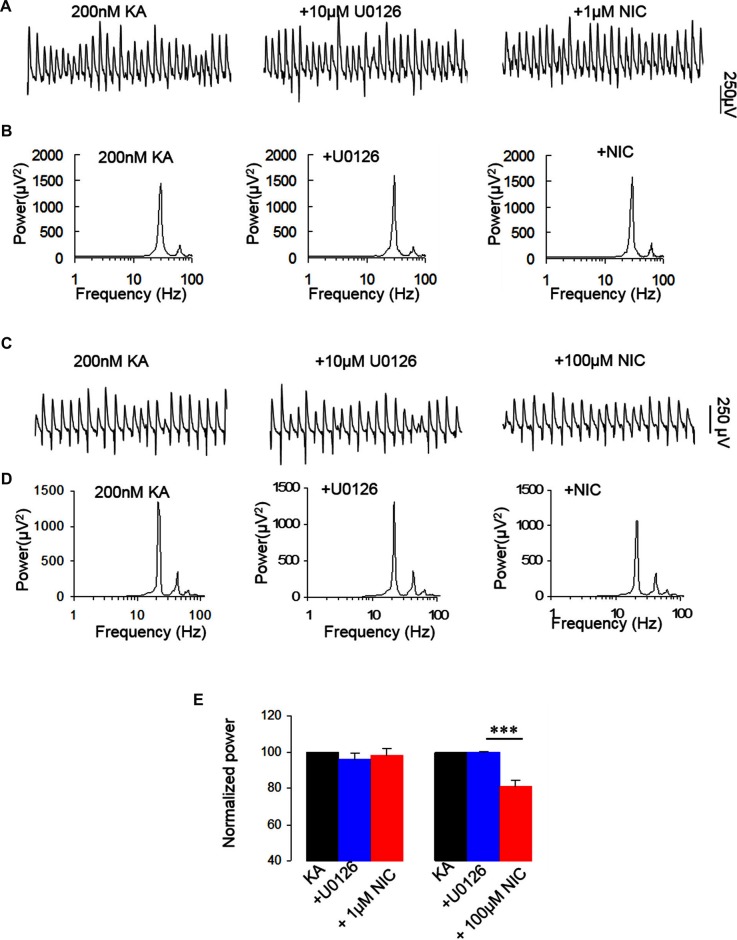
The effect of MEK kinase inhibitor on the nicotinic modulation of γ oscillations. (A,C) The extracellular field recordings from CA3 pyramidale for the kainate alone, in the presence of the ERK1/2 inhibitor, 10 μM 1,4-Diamino-2,3-dicyano-1,4-bis(o-aminophenylmercapto) butadiene (U0126; 40 min after nicotine), and after additional application of 1 μM nicotine (30 min after nicotine; A) or 100 μM nicotine (30 min after nicotine; C). (B,D) The power spectra corresponding to (A,C). (E) γ power as % of baseline γ power for the kainate alone, U0126 and with additional application of 1 μM nicotine (n = 8) or 100 μM nicotine (n = 8; ***P < 0.001, one way RM ANOVA, compared with U0126 alone).